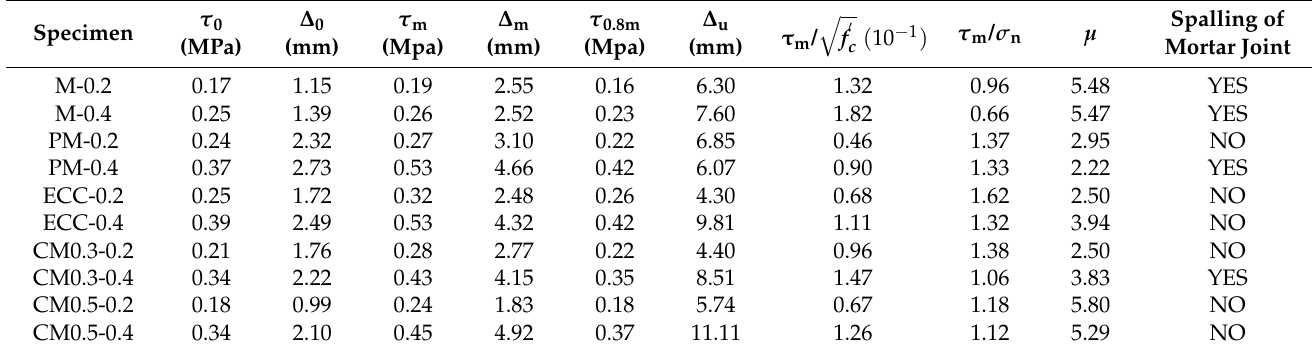
Figure 13. Hysteretic response of specimens: ( a ) M-0.2, ( b ) M-0.4, ( c ) PM-0.2, ( d ) PM-0.4, ( e ) ECC-0.2, ( f ) ECC-0.4, ( g ) CM0.3-0.2, ( h ) CM0.3-0.4, ( i ) CM0.5-0.2 and ( j ) CM0.5-0.4. Table 3. Experimental results of the specimens.